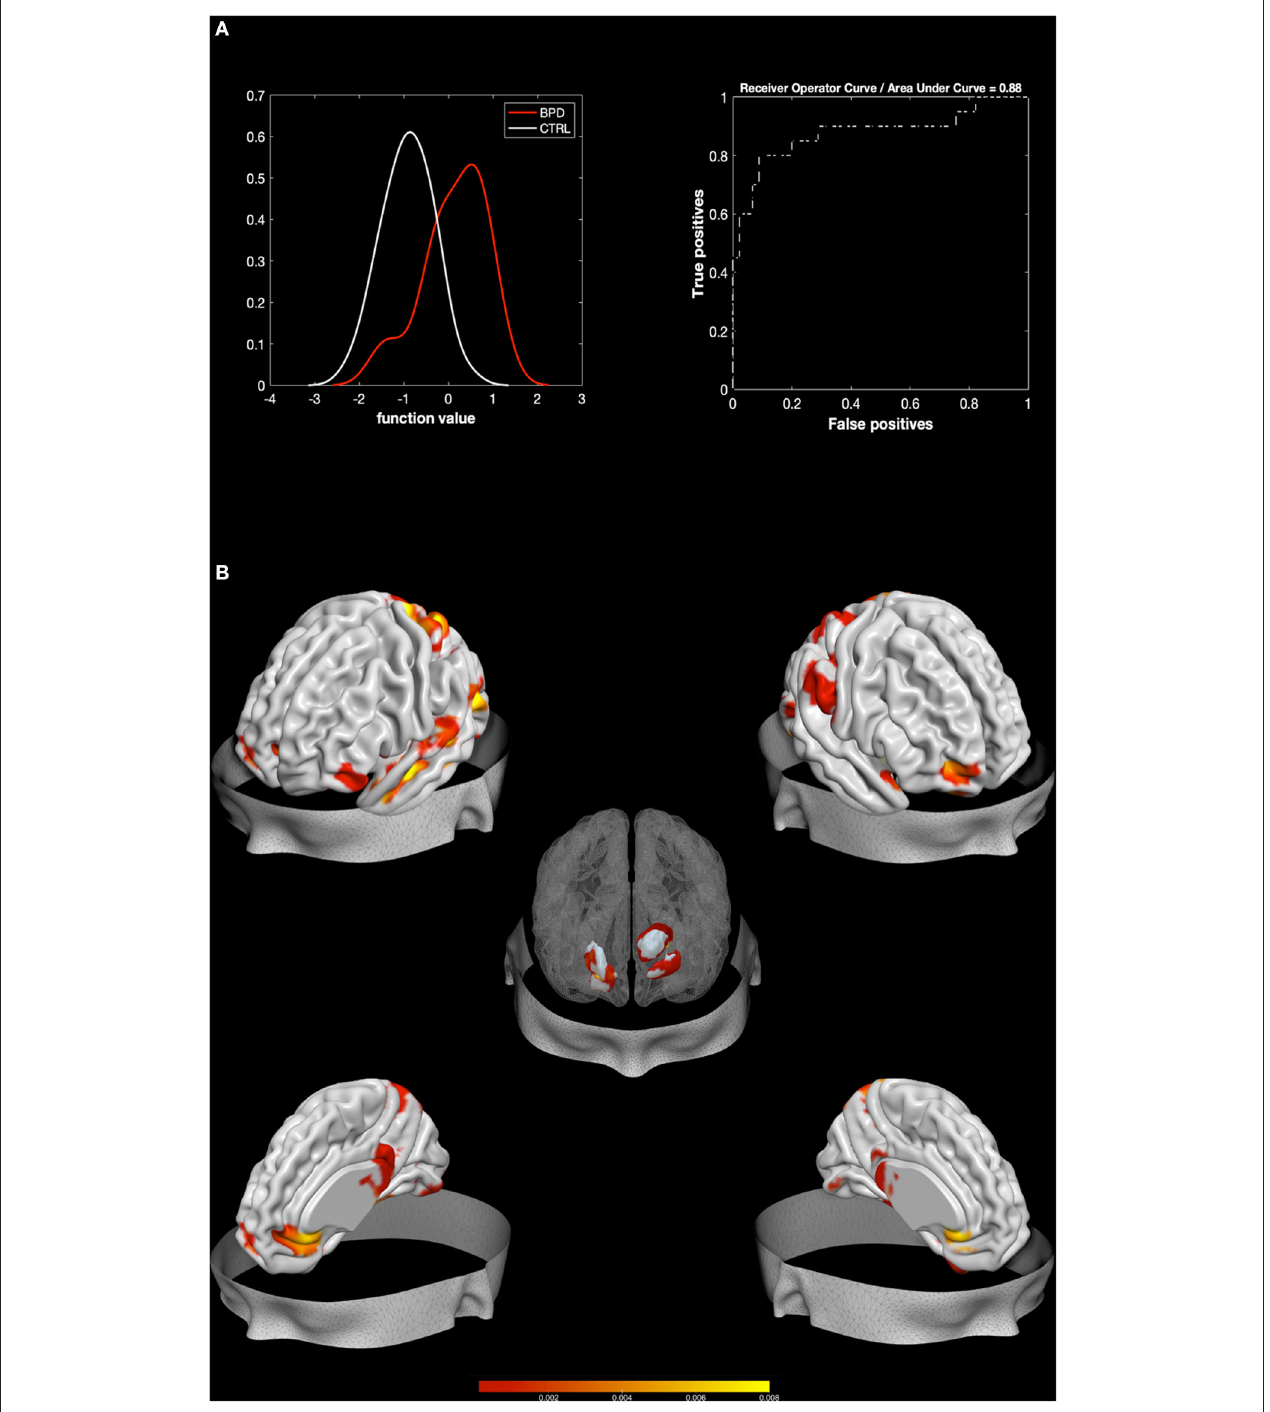
FIGURE 1 | Results from BPD against HC. Multiple Kernel Learning machine classification of patients with Borderline Personality Disorder (BPD) and healthy controls (HC) based on structural (GM) features. (A) Left: Density version of histogram plot of function values. Right: Receiver Operator Curve, Areas Under the Curve = 0.88. ROI weights in percentage and in voxel size are displayed in the two bar plots. (B) Surface plots, including subcortical reconstruction of the significant regions. temporal area, the right putamen, the left caudate, and pallidum, the right inferior frontal cortex, the right the right superior part of the OFC among others (see amygdala, portions of the cerebellum, the right superior Figure 2 ; Table 3 temporal pole, the right fusiform, the right inferior